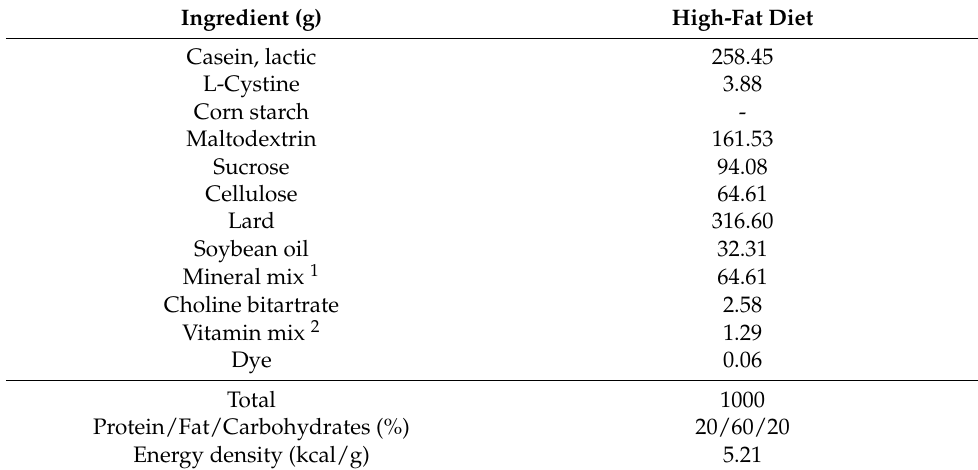
Table 1. Composition of the high-fat